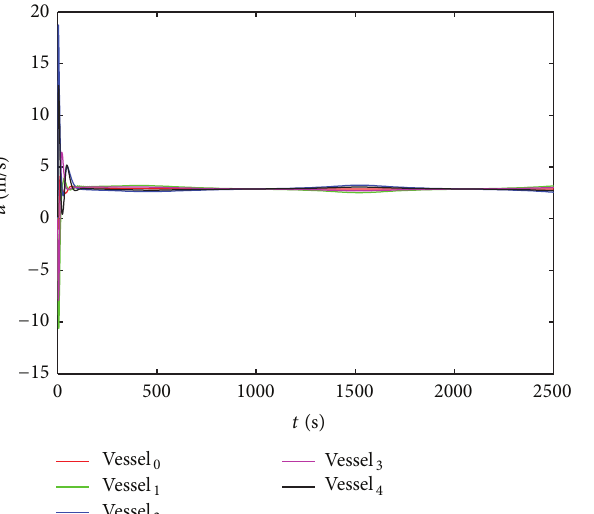
Figure 4: The surge velocities consensus of the vessels.